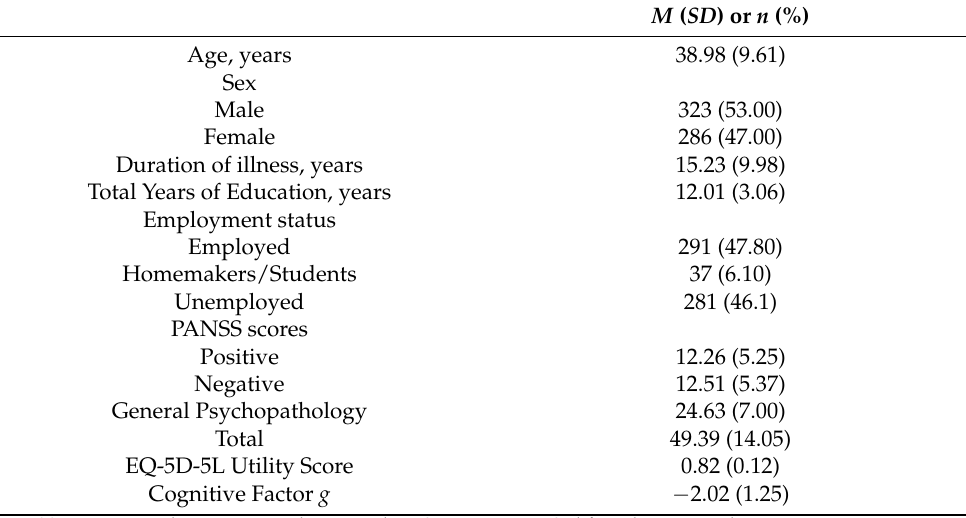
Table 1. Socio-demographic and clinical characteristics of the Participants ( n = 609).